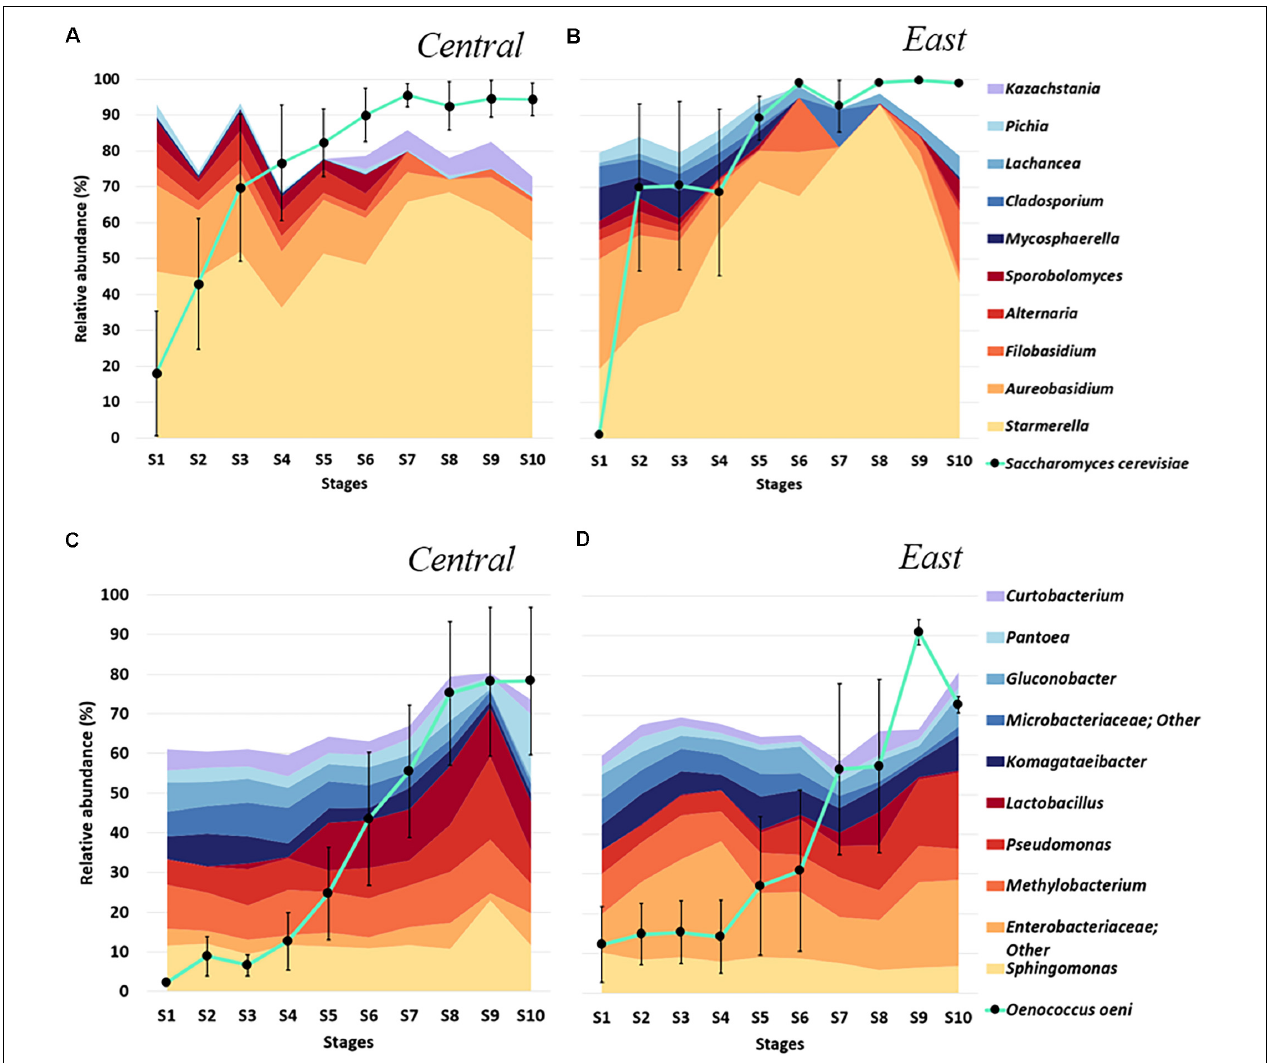
FIGURE 3 | Microbial diversity across fermentation stages of Chambourcin winemaking in two Pennsylvania regions, (A,C) Central and (B,D) East. Relative taxonomic distribution at the genus level for the top 10 (A) fungal and (C) bacteria communities throughout fermentation minus S. cerevisiae and O. oeni ( • connected by turquoise line). The taxonomic distribution at each timepoint represents the average abundance of microbial taxa detected in all samples from one region at each fermentation stage. Relative abundances of S. cerevisiae and O. oeni were obtained from their reads normalized to total sample reads. Error bars denote variance (Standard Error of the Mean, SEM) of S. cerevisiae and O. oeni